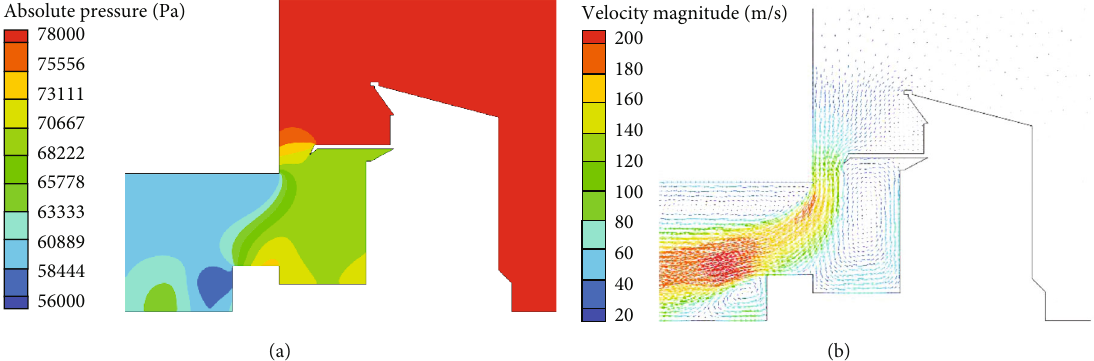
Figure 7: CFD study on the fl ow fi eld near the outlet of the out fl ow valve ( opening = 10 mm , ambientpressure = 60kPa , differential pressure = 20kPa ), (a) pressure distribution, (b) velocity vectors.